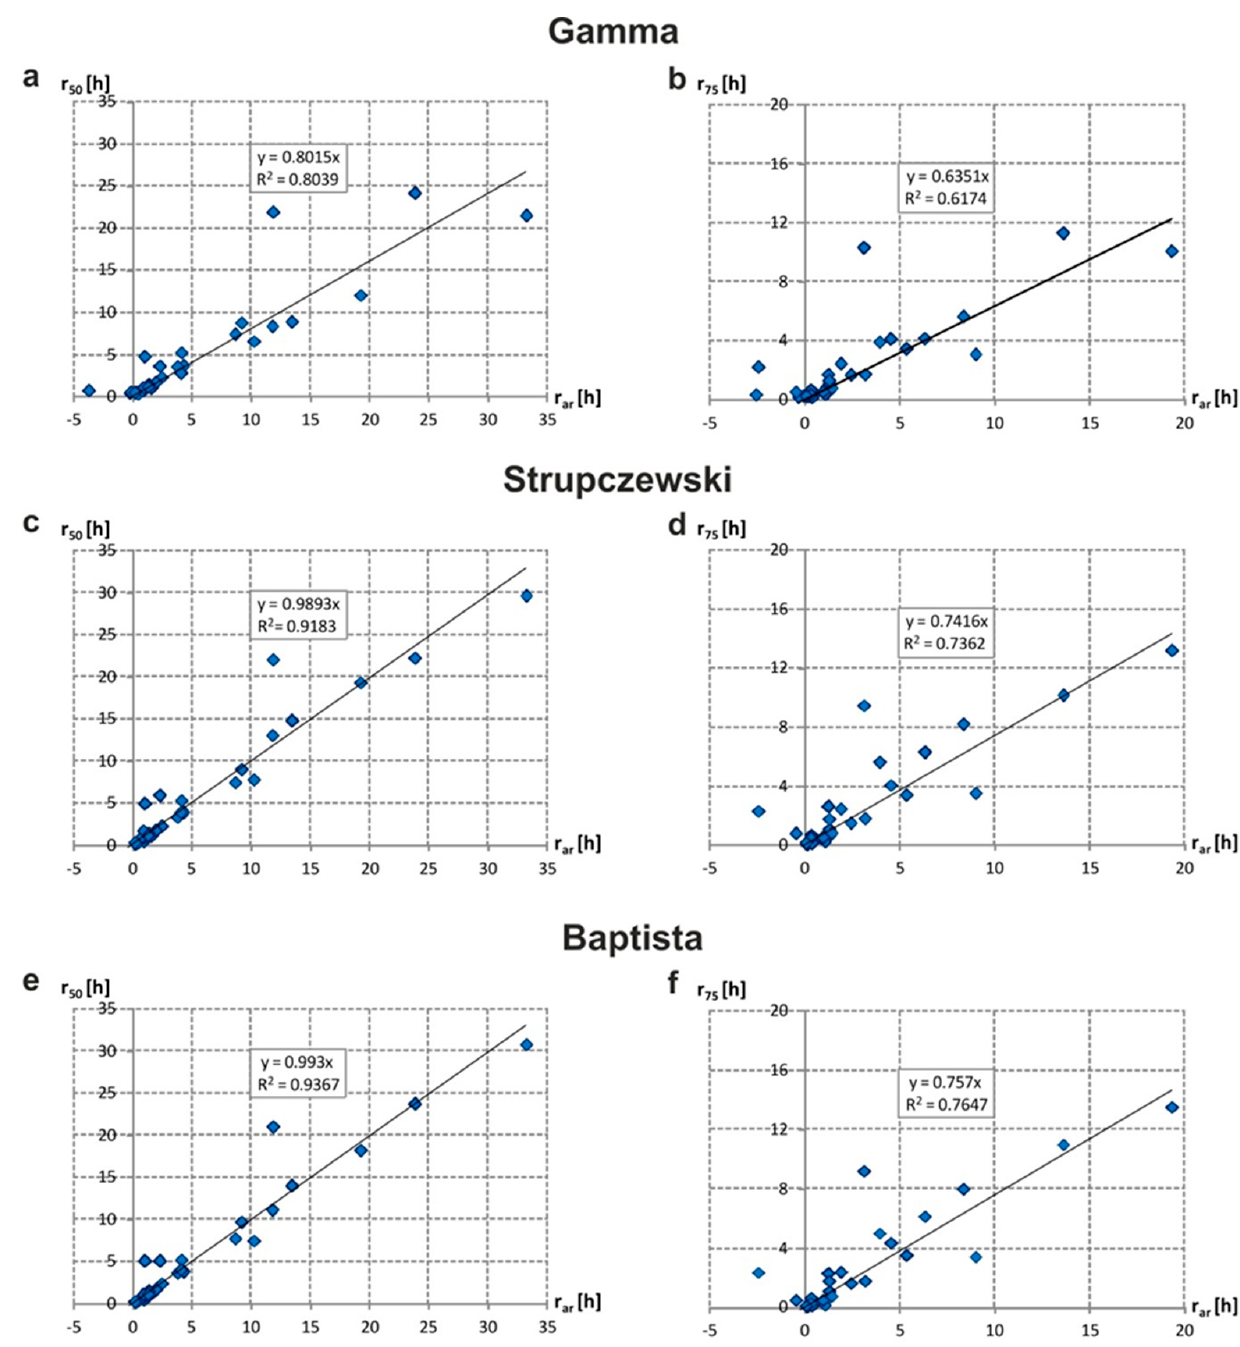
Figure 9. The values of flood wave gravity centers estimated from parametric hydrograph methods (Gamma, Strupczewski, Baptista) r p versus values estimated with nonparametric DFH by the Archer method r ar truncated at p = 50% (left panel) and at p = 75% (right panel). The comparison of volumes obtained from parametric hydrographs with nonpara- metric hydrographs shows the high compliance ( R 2 exceeding 0.99 for level of truncations p = 50% and 0.96 for p = 75%) in all three distribution methods (Figure